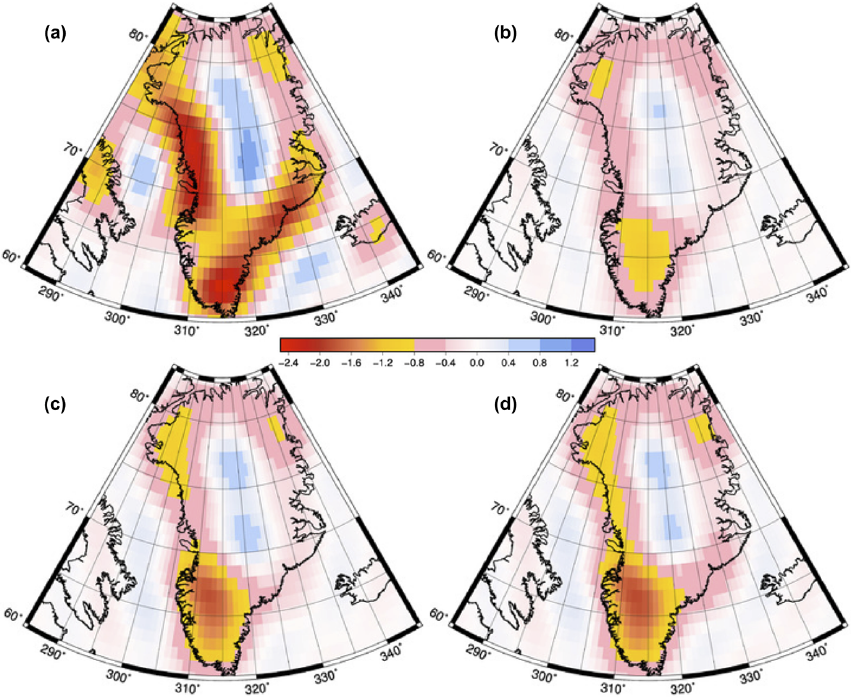
Figure 9. Total mass change between 2003 and 2012 for GRACE observations (a) , RACMO2-SMB-only model (b) , SMB-only simula- tion (c) , and SMB + FF simulation (d) . Units are meters of water equivalent height.